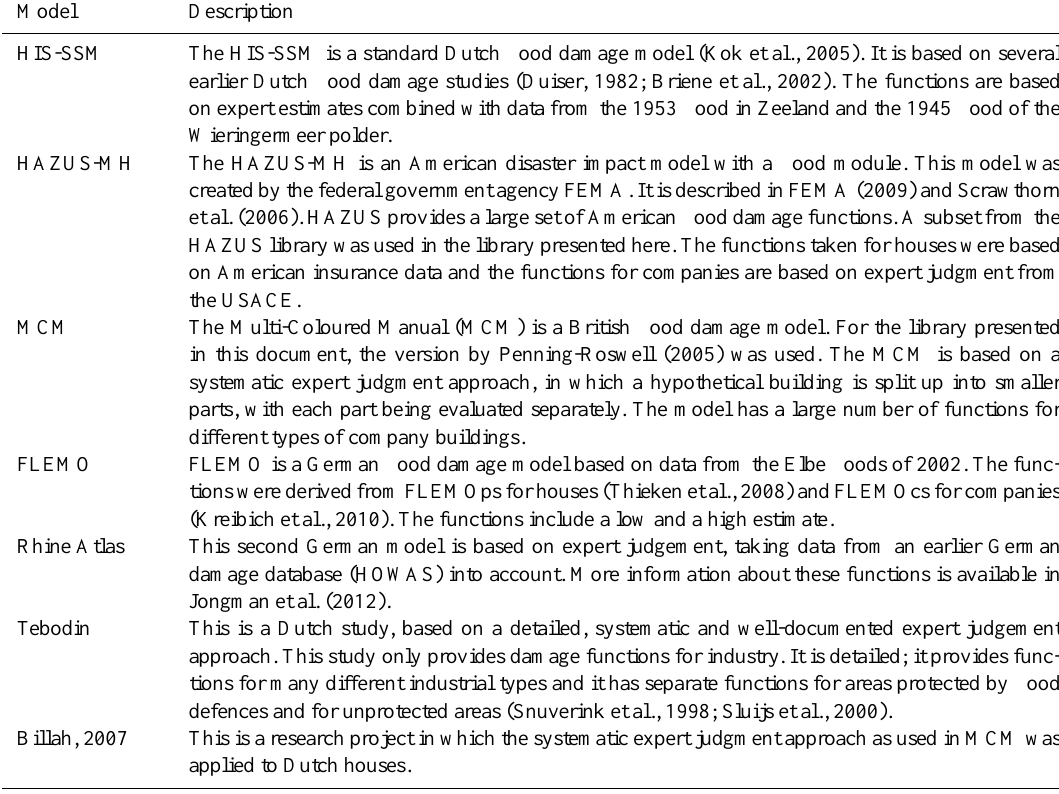
Table 2. Overview of the damage models from which damage functions are included in the damage function library.